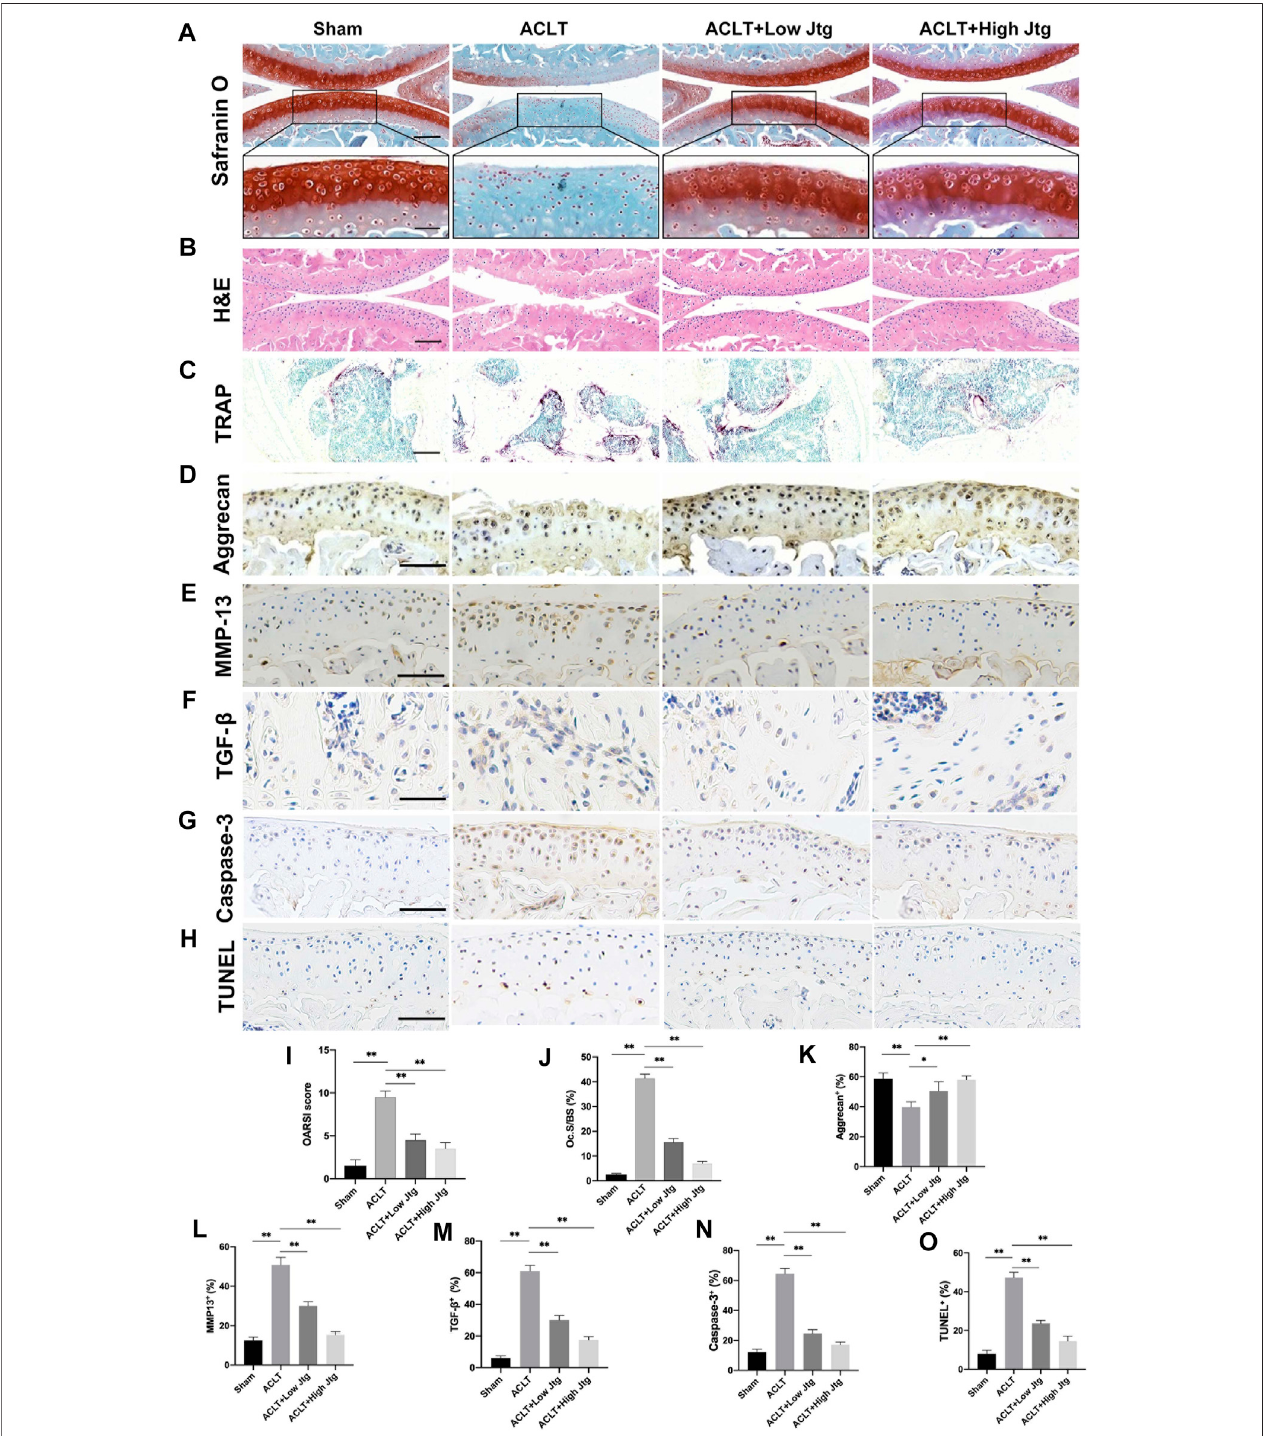
FIGURE5| HistologicalanalysisofJtgtreatmentinamouse anteriorcruciate ligament transection(ACLT)model invivo . (A) SafraninOstaining,scale bar,200 μ m (top panels); 100 μ m (bottom panels). (B) HE staining, scale bar, 200 μ m. (C) Tartrate-resistant acid phosphatase (TRAP) staining, scale bar, 200 μ m. (D – H) Immunohistochemical staining of aggrecan, MMP-13, TGF- β , Caspase-3 and TUNEL expression, scale bar, 100 μ m. (I) Osteoarthritis Research Society International (OARSI) score indicate cartilage degeneration at 4 weeks after the ACLT operation. (J) Quantitative analysis of osteoclast surface per millimeter bone perimeter (Oc.s/BS) indicate subchondral bone remodeling at 2 weeks after the ACLT operation. (K – O) The quantitative analysis of positive cells of aggrecan, MMP-13, TGF- β , Caspase-3, and TUNEL in each group. *Compared with the ACLT group (* p < 0.05; ** p < 0.01).